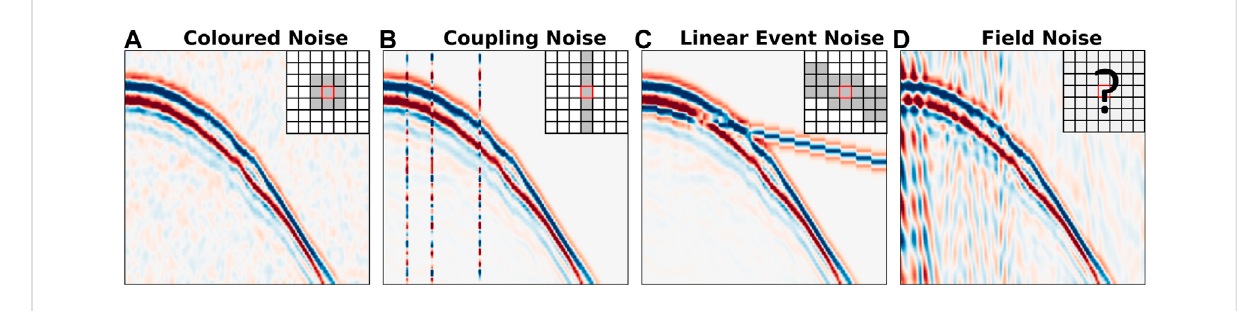
FIGURE 2 Different noise types and their respective blind-masks. (A) Coloured noise, (B) trace-wise noise, (C) noise from a far away event, and (D) fi eld